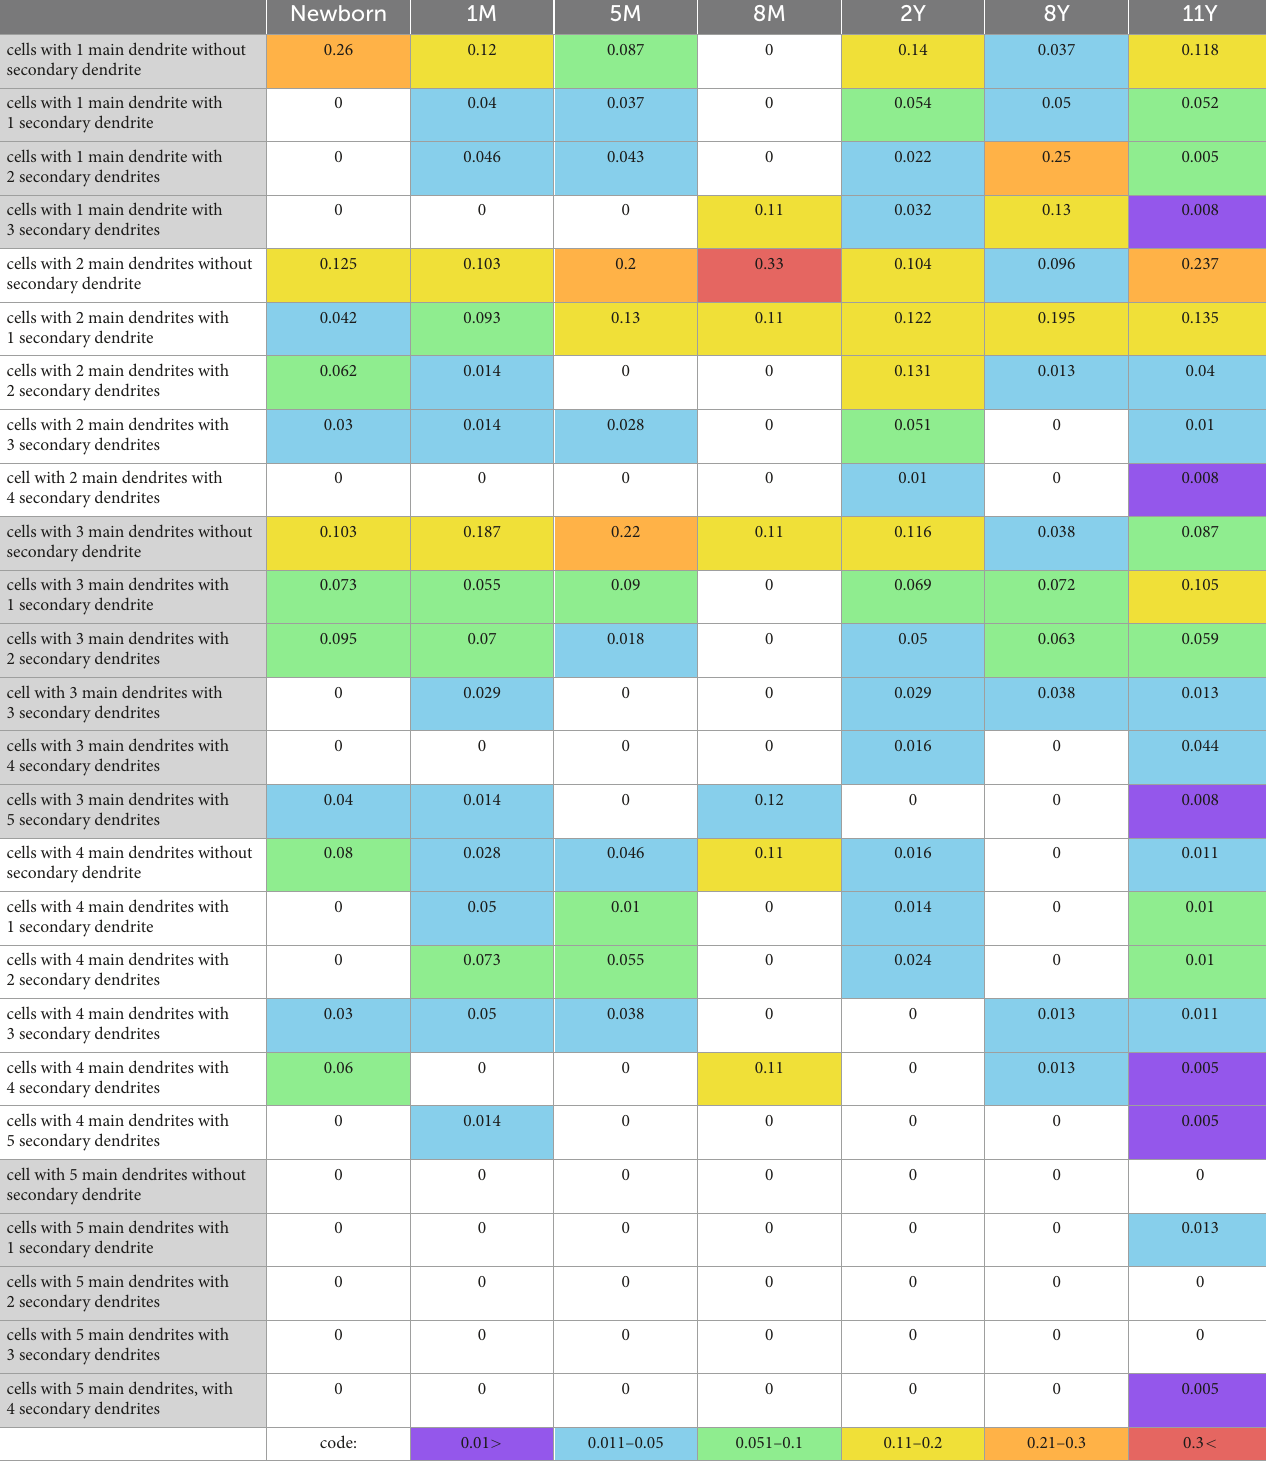
TABLE 4 Proportion of PV-immunoreactive cells with different numbers of main and secondary dendrites. Newborn